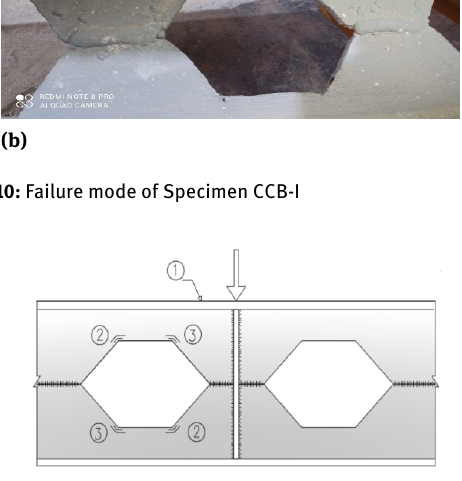
Figure 11: Sequence of yielding due to Vierendeel bending [7]